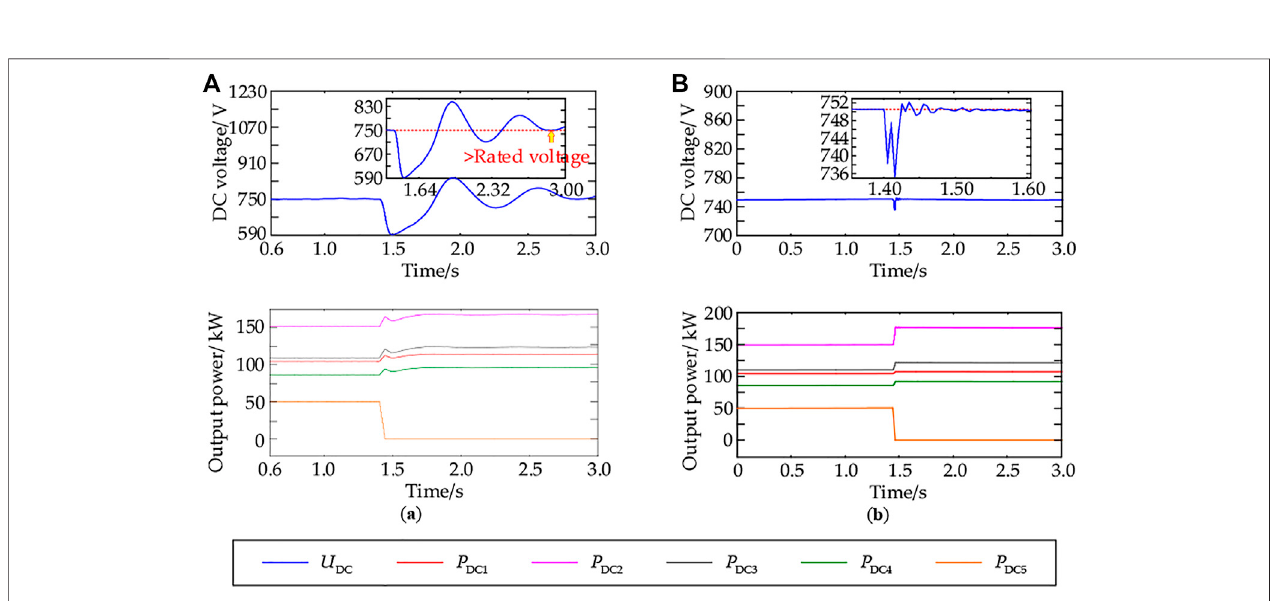
FIGURE 10 | Simulation waveforms of the VSC with fi xed DC voltage control exiting operation: (A) simulation waves based on traditional droop control; (B) simulation waves based on adaptive droop control.